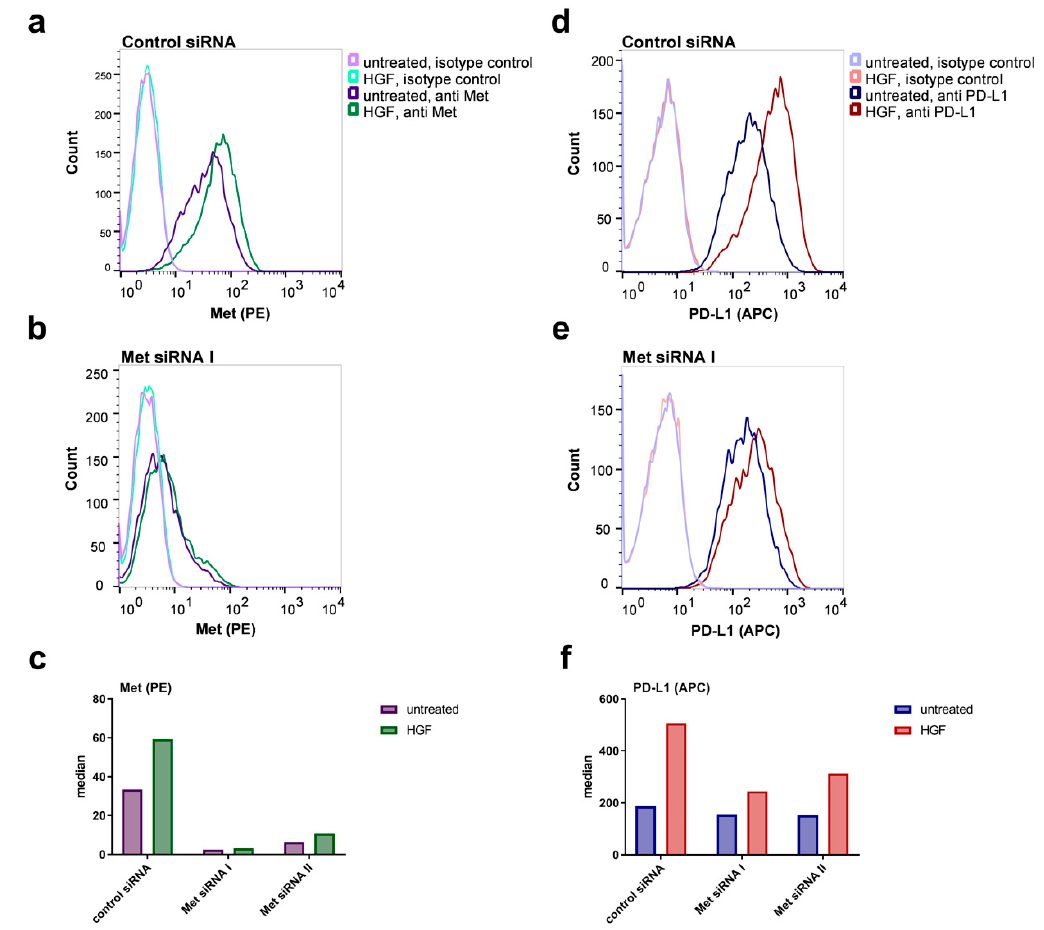
Figure 3. Increased PD-L1 concentration on the cell surface is mesenchymal–epithelial transition (Met)-receptor-dependent. Detroit 562 cells were transfected with two different siRNA constructs specific for the Met receptor (Met siRNA I and II) or a control siRNA. Forty-eight hours after transfection, cells were treated with 50 ng/mL HGF or remained untreated. Cells were subjected to flow cytometry after an additional 48 h using a phycoerythrin (PE)-conjugated Met specific antibody in ( a ), ( b ), and ( c ), an allophycocyanin (APC)-conjugated PD-L1 specific antibody in ( d ), ( e ), and ( f ) or the corresponding isotype controls (light-colored curves). Panels ( a ), ( b ), ( d ), and ( e ) show histograms of cells transfected with the indicated siRNAs, ( c ) and ( f ) are the median fluorescence of the corresponding histograms shown in ( a ), ( b ), ( d ), and ( e ) (isotype controls subtracted). One typical result out of six experiments is shown.